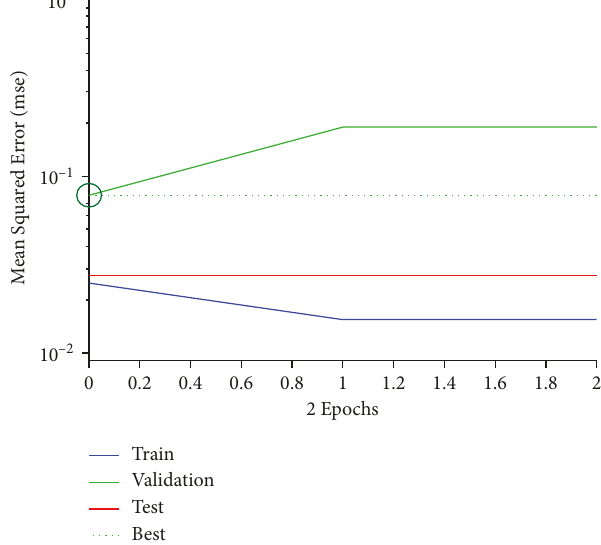
Figure 5: Plot of the training